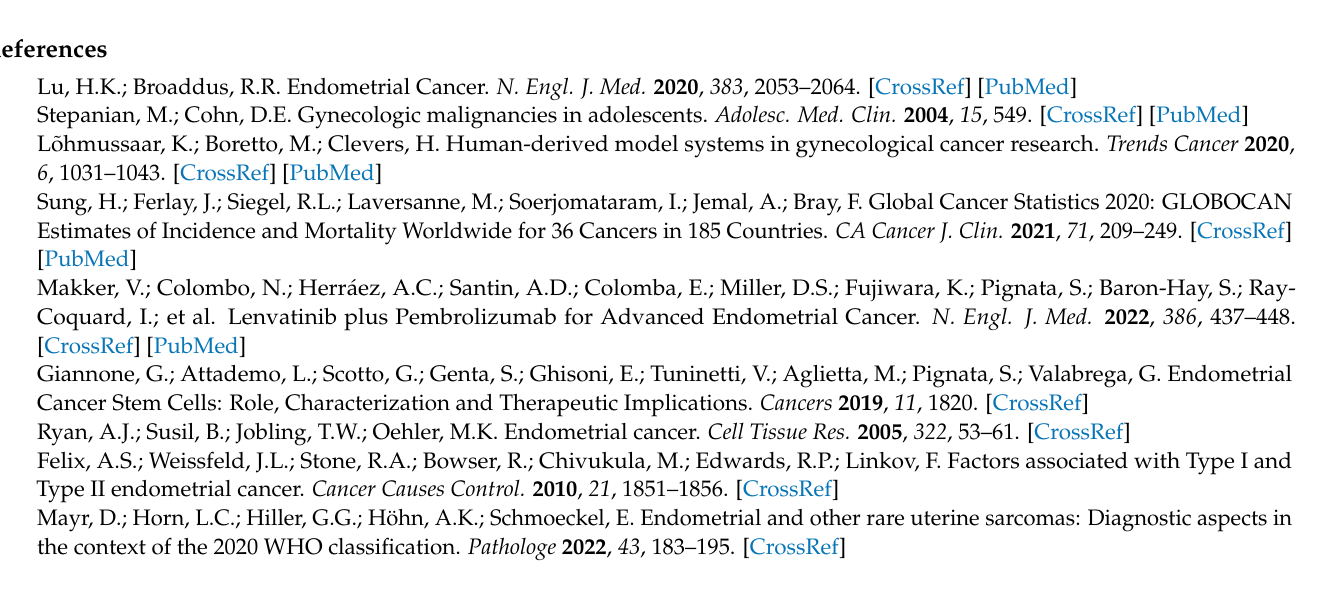
cell populations. Table S3: Results of Mann-Whitney test between normal and cancer samples for G0/G1. Table S4: ROC Analysis results for discrimination between normal and cancer cells, based on G0/G1 values and determination of optimal cutoff